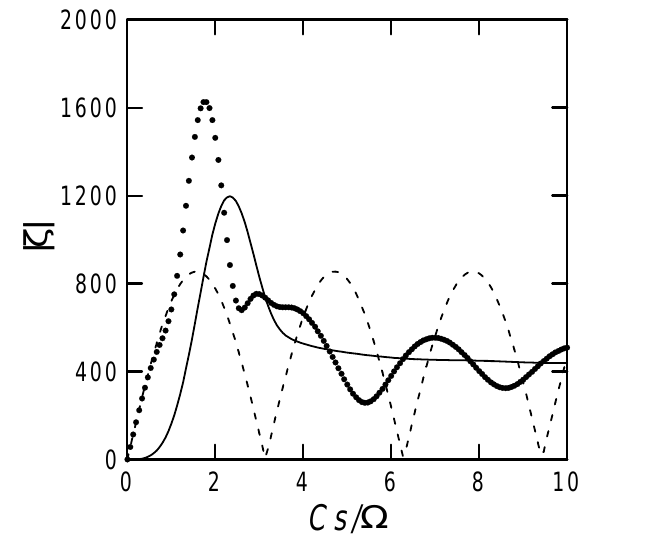
FIG. 4. Same as in Fig. 3, but (cid:120) (cid:173) (cid:49)(cid:48) and (cid:97) (cid:173) (cid:50)